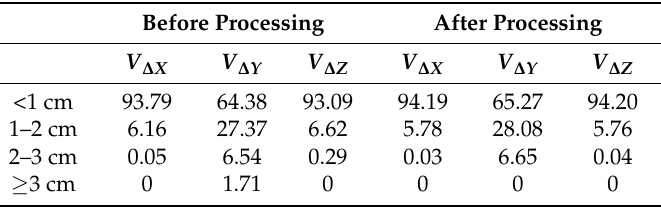
Table 3. Statistics of baseline vectors’ corrections of the spatial GNSS monitoring network